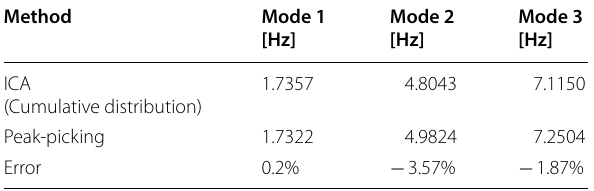
Table 5 The identified natural frequencies.